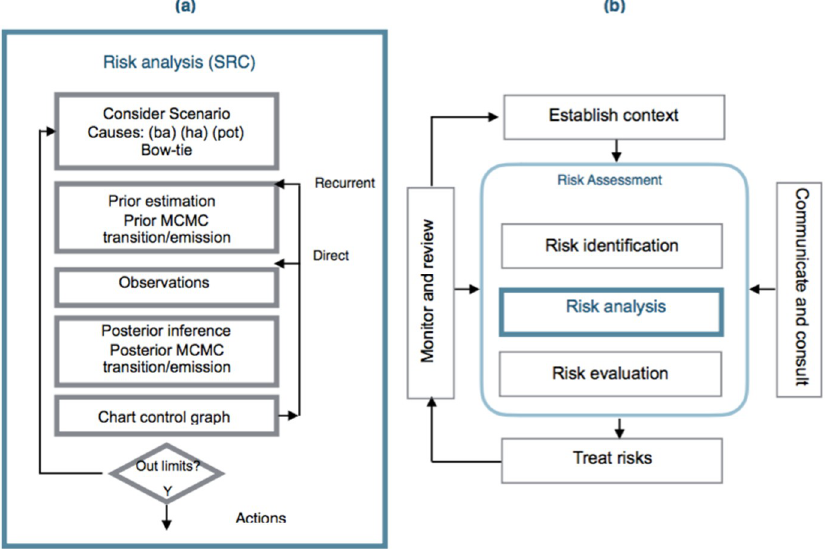
Figure 4. ( a ) Statistical Risk Control (SRC) methodology; ( b ) position in the risk-assessment scheme (adapted from [5]).